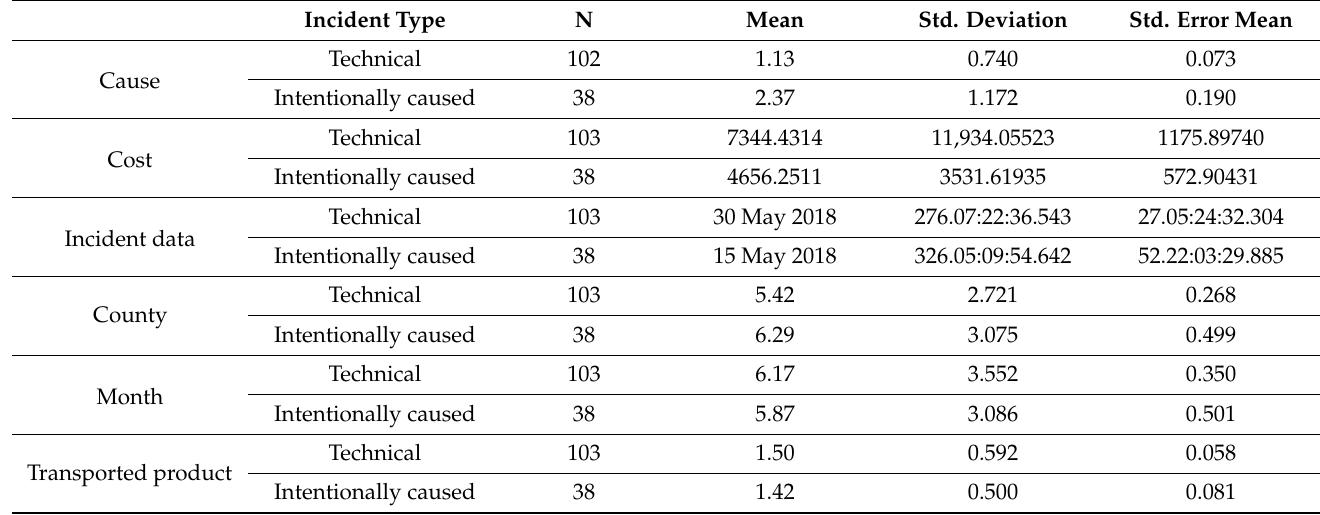
Table 21. Descriptive statistics of Student’s t